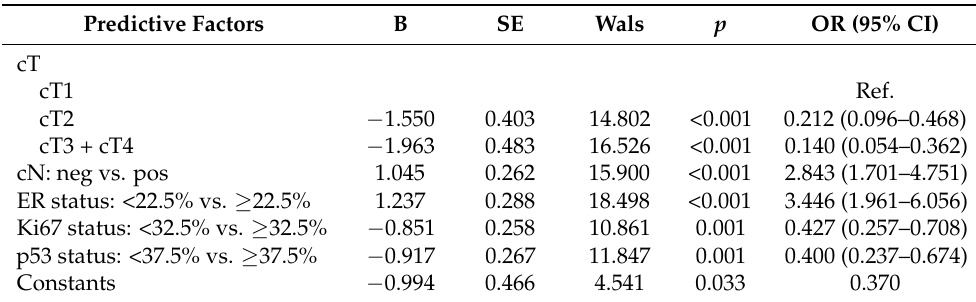
Table 3. Results of binary logistic regression